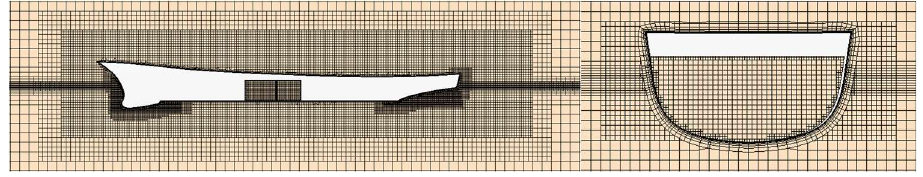
Figure 10. Comparison of sinkage obtained by computation and experiment for intact ship at differ- ent forward speeds.